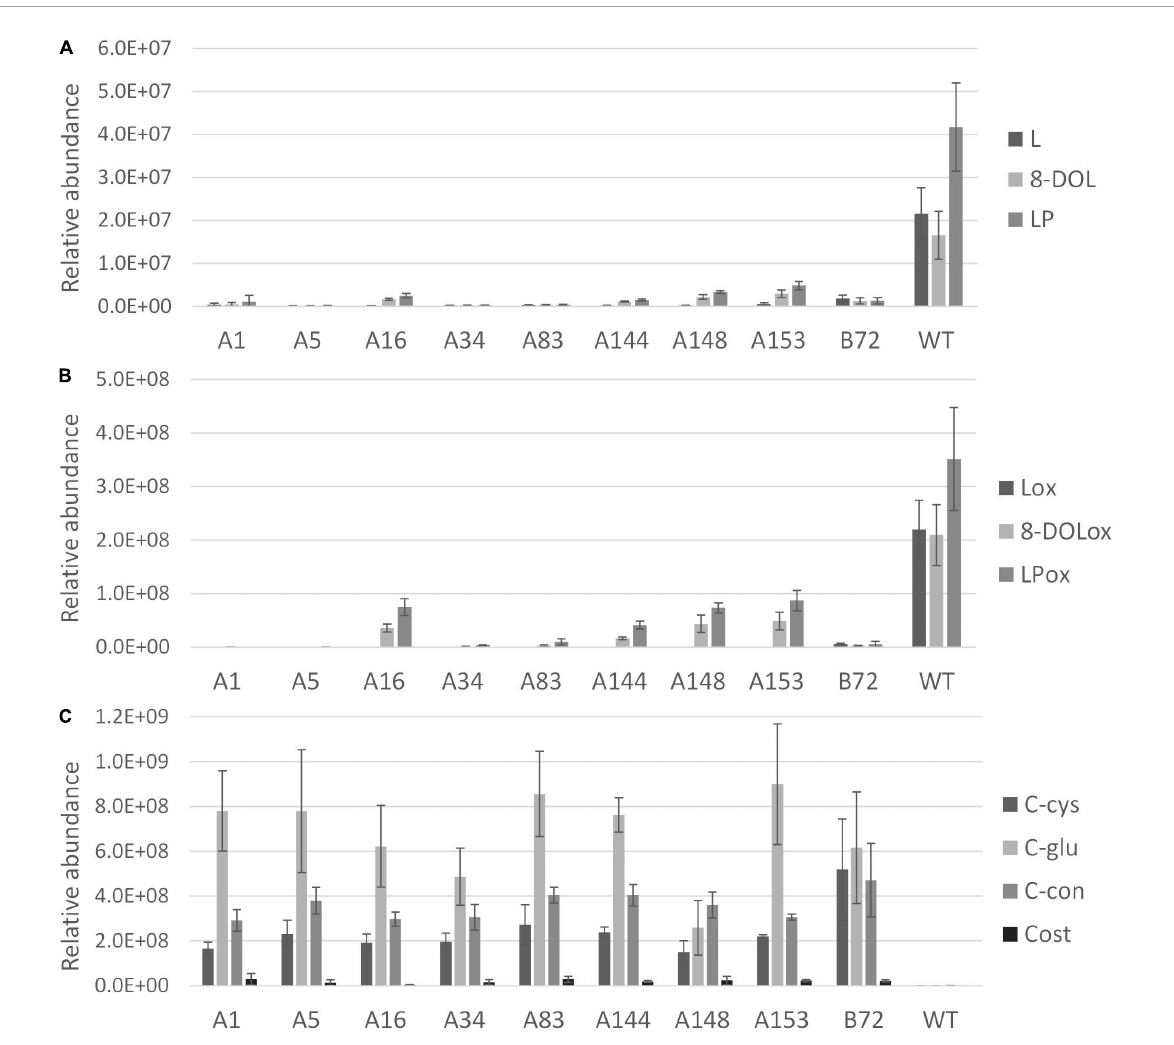
FIGURE4 Terpene profile analysis of gene edited chicory lines by LC-Orbitrap-FTMS. Peak area of terpenes in roots of 9 genome edited chicory lines (A1, A5, A16, A34, A83, A144, A148, A153, and B72) were analyzed in triplicate and compared to WT chicory lines ( n = 11). Panel (A) shows reduction of lactucin (L), 8-deoxylactucin (8-DOL), and lactucopicrin (LP) in the gene edited lines. Panel (B) shows the reduction of lactucin 15-oxalate (Lox), 8-deoxylactucin 15-oxalate (8-DOLox), and lactucopicrin 15-oxalate (LPox) in the gene edited lines. Panel (C) shows the accumulation